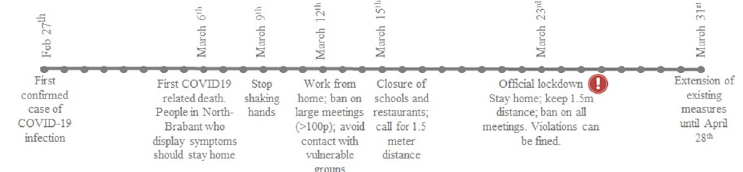
Fig 2. Timeline of the COVID-19 outbreak and the implementation of social distancing directives in The Netherlands.